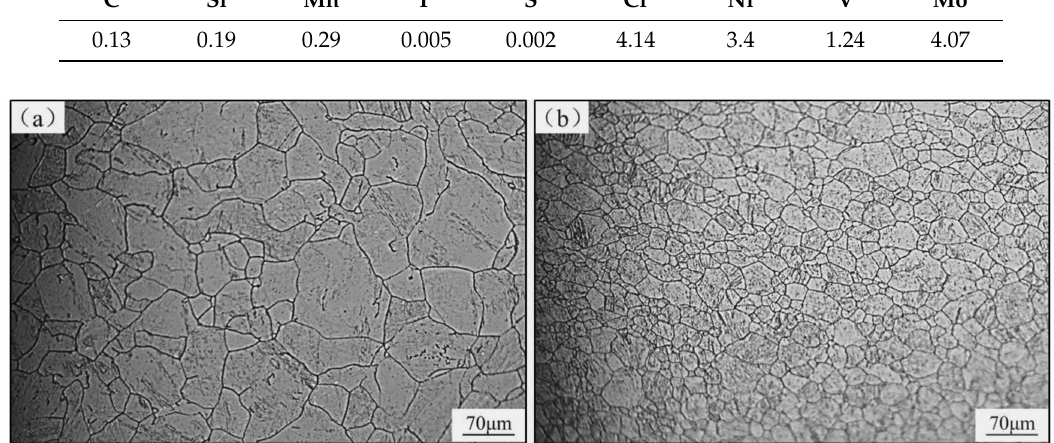
Figure 1. Optical micrographs of the M50NiL steel samples with coarse and fine grains prior to deformation: ( a ) coarse-grained sample (obtained by heating at 1150 ◦ C for 30 min); ( b ) fine-grained sample (obtained by heating at 1100 ◦ C for 5 min).